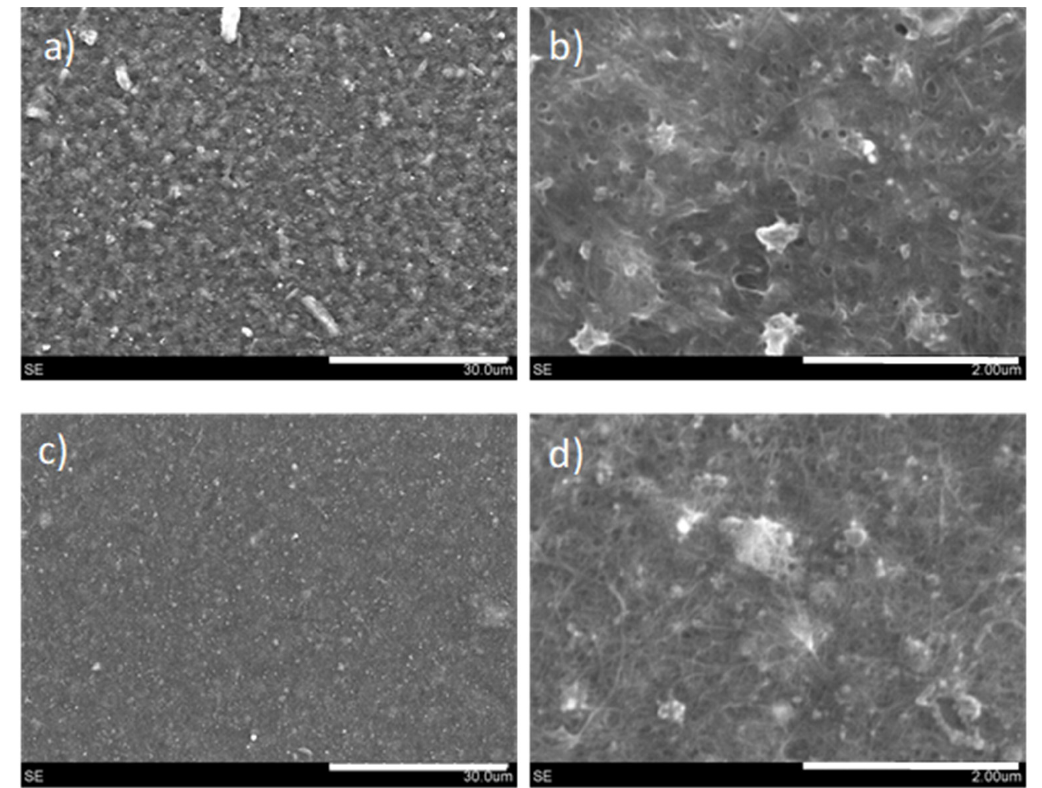
Figure 9. SEM images from films obtained with high-viscosity pastes, before ( a , b ) and after ( c , d ) heat treatment at 400 °C. Scale bars (in white) = 30 μ m ( a,c ) and 2 μ m ( b,d ).